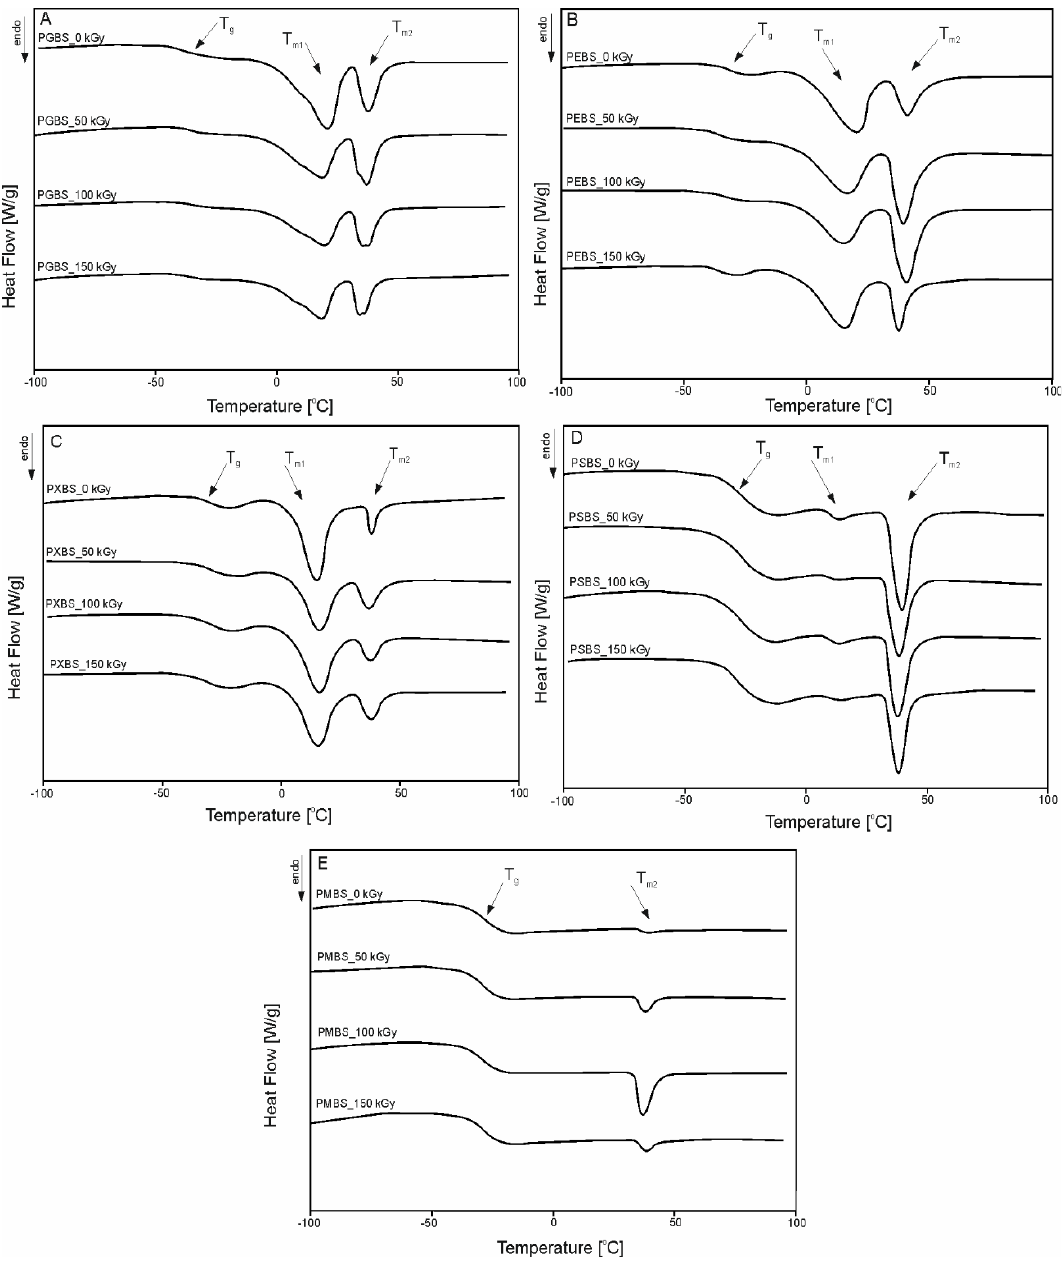
Figure 4 . First-heating differential scanning calorimetry (DSC) thermograms of ( A ) PGBS, ( B ) PEBS, Figure 4. First-heating di ff erential scanning calorimetry (DSC) thermograms of ( A ) PGBS, ( B ) PEBS, ( C ) PXBS, ( D ) PSBS, and ( E ) PMBS before and after irradiation. ( C ) PXBS, ( D ) PSBS, and ( E ) PMBS before and after